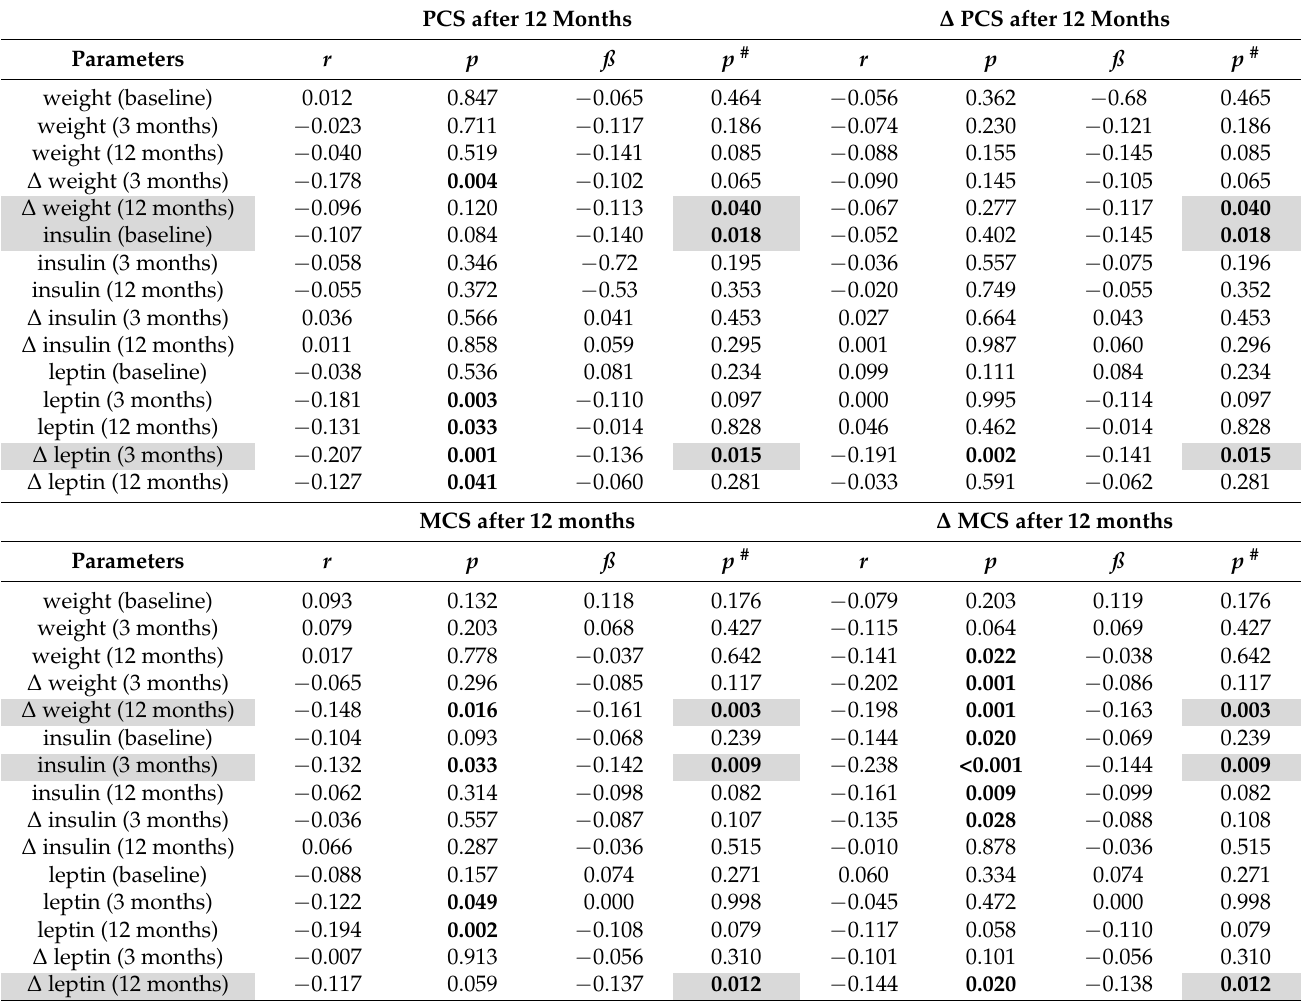
Table 2. Associations between PCS and MCS with weight, insulin, and